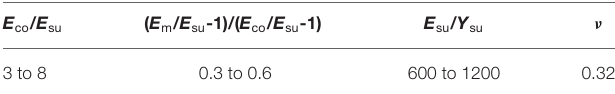
TABLE 3 | Range of parameters for which similar behavior as described in the Strengthening Effect of Bilayer Coated Spheres section was observed ( Y co / Y su = E co / E su and Y m / Y su = E m / E su